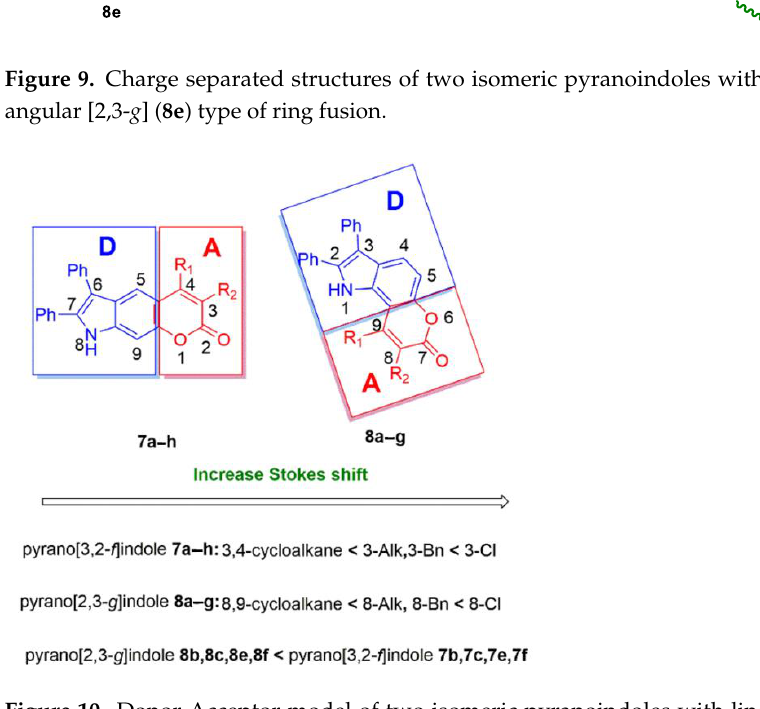
Figure 10. Donor-Acceptor model of two isomeric pyranoindoles with linear [3,2- f ] and angular [2,3- g ] type of ring fusion and a general influence 3,4-/8,9-pyranol substitution and electron transfer angle on the Stokes shift values of compounds 7 – 8 .